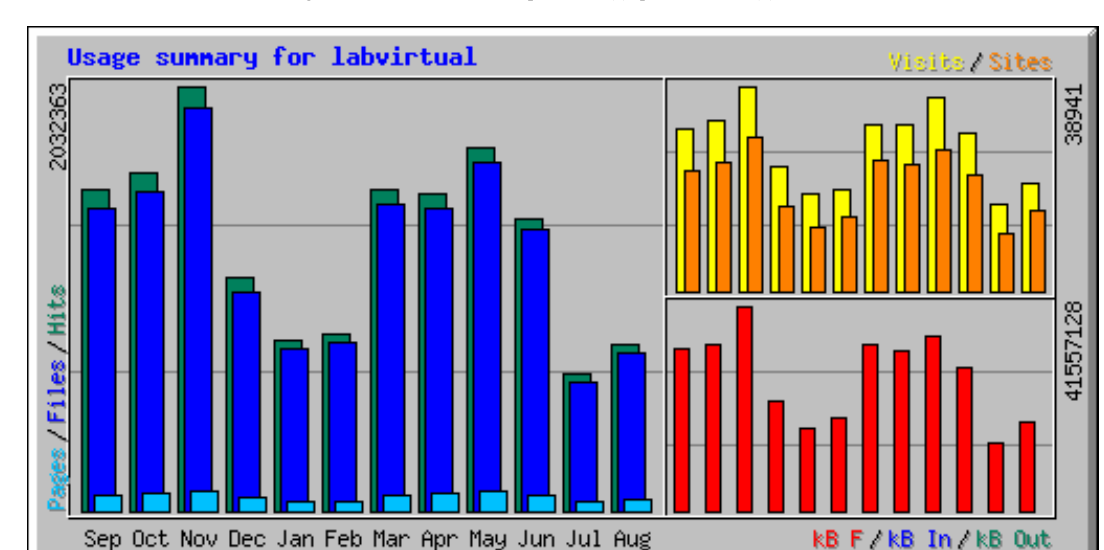
Figure 3. Statistics of accesses to LABVIRTUAL in